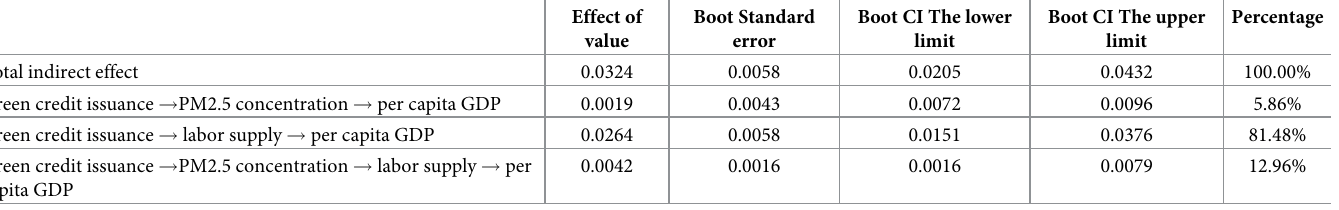
Table 8. Bootstrap sampling for the mediating effect of labor